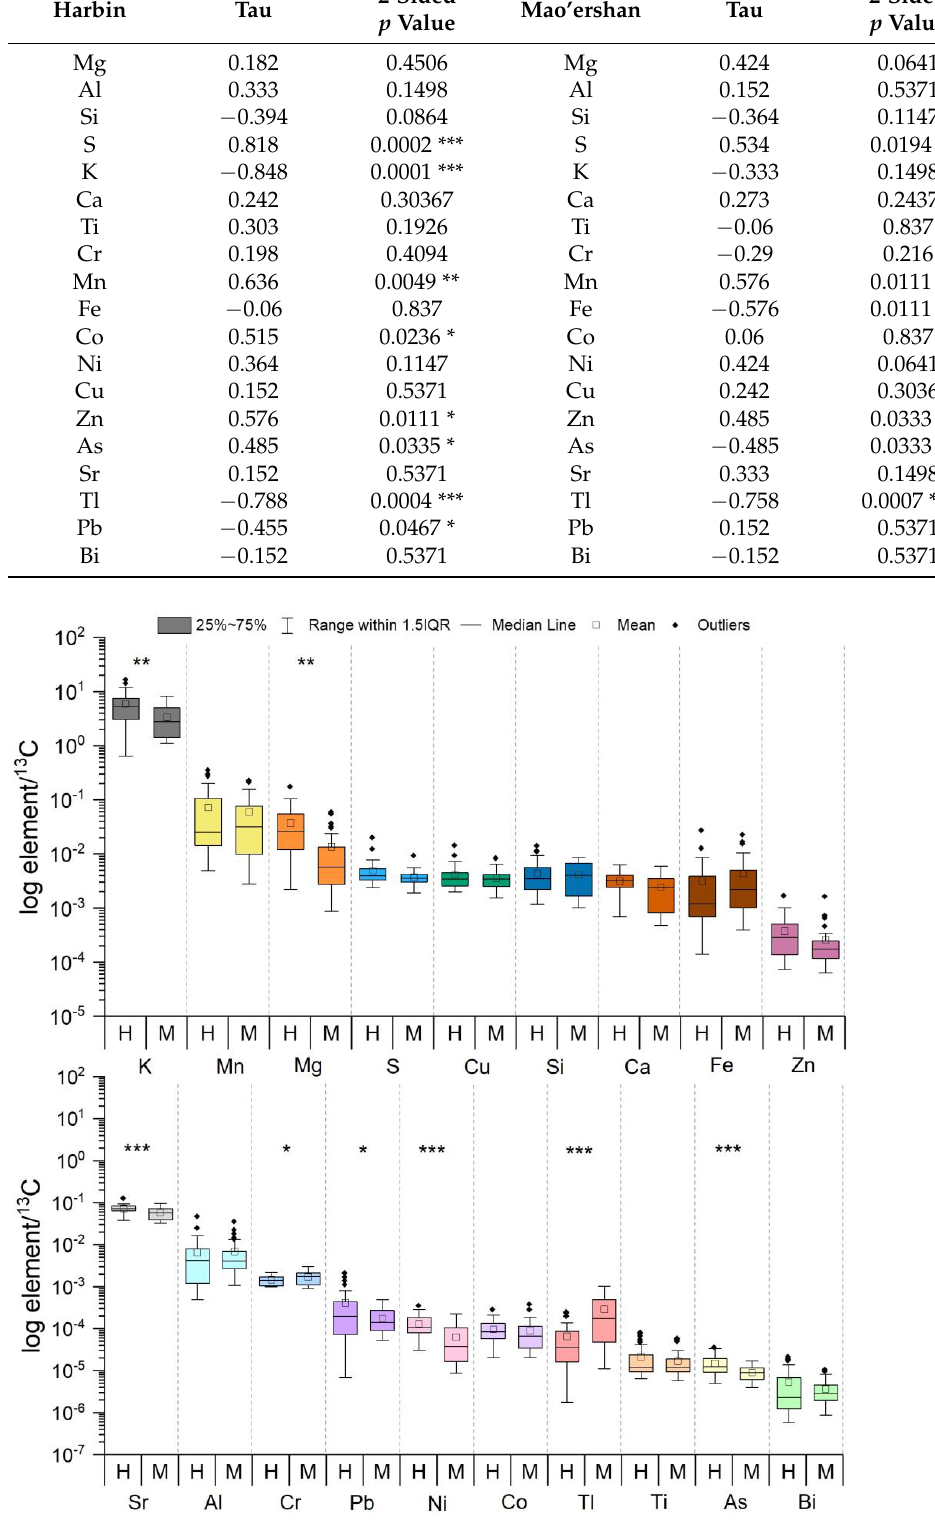
Figure 4. Box and Whisker plots used to determine which means were significantly different from others at the Harbin and Mao’ershan sites. Grouped as essential nutrients on the upper plot, trace metals on the lower plot. For the p values from Tukey’s mean comparison test: “*” p < 0.05, “**” p < 0.01, “***” p < 0.001. H = Harbin, M = Mao’ershan. Temporal mean variation in Mg, K, Zn, Ni, As, Sr, Tl, Pb and Cu showed statistically significant differences (Kruskal – Wallis test at p ≤ 0.05) between the Harbin and Mao’e r- shan sites for the two evaluated periods (Figure 5). Significant differences in the heart- wood were found for K, Ni and Tl ( p < 0.001), for Zn and Pb ( p = 0.005 and p = 0.002, respectively), and for Mg, Sr and Cu ( p = 0.012, p = 0.016 and p = 0.03, respectively). On the other hand, significant differences in the sapwood were found only for Mg, As, Sr and Tl at p = 0.03.